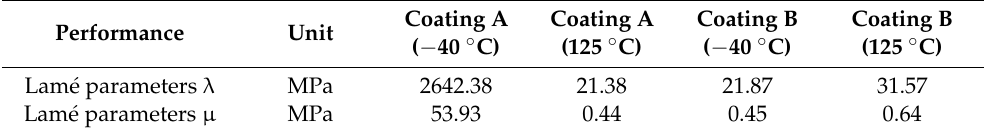
Table 7. Material Lamé parameters input in 2D FEA modeling.